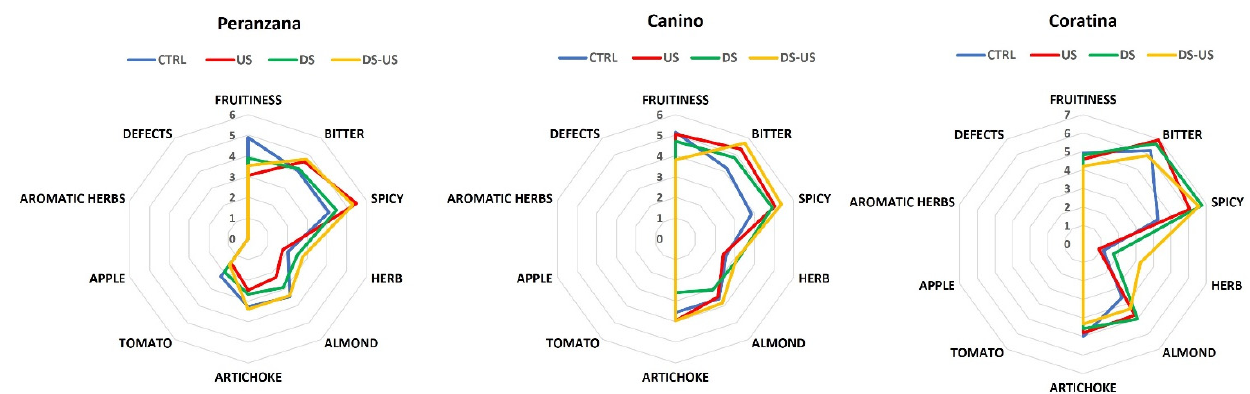
Figure 8. Sensorial profile of Peranzana, Coratina, and Canino EVOOs. CTRL = control test, US = ultrasound test, DS = destoned test, DS-US = destoned-ultrasound test.